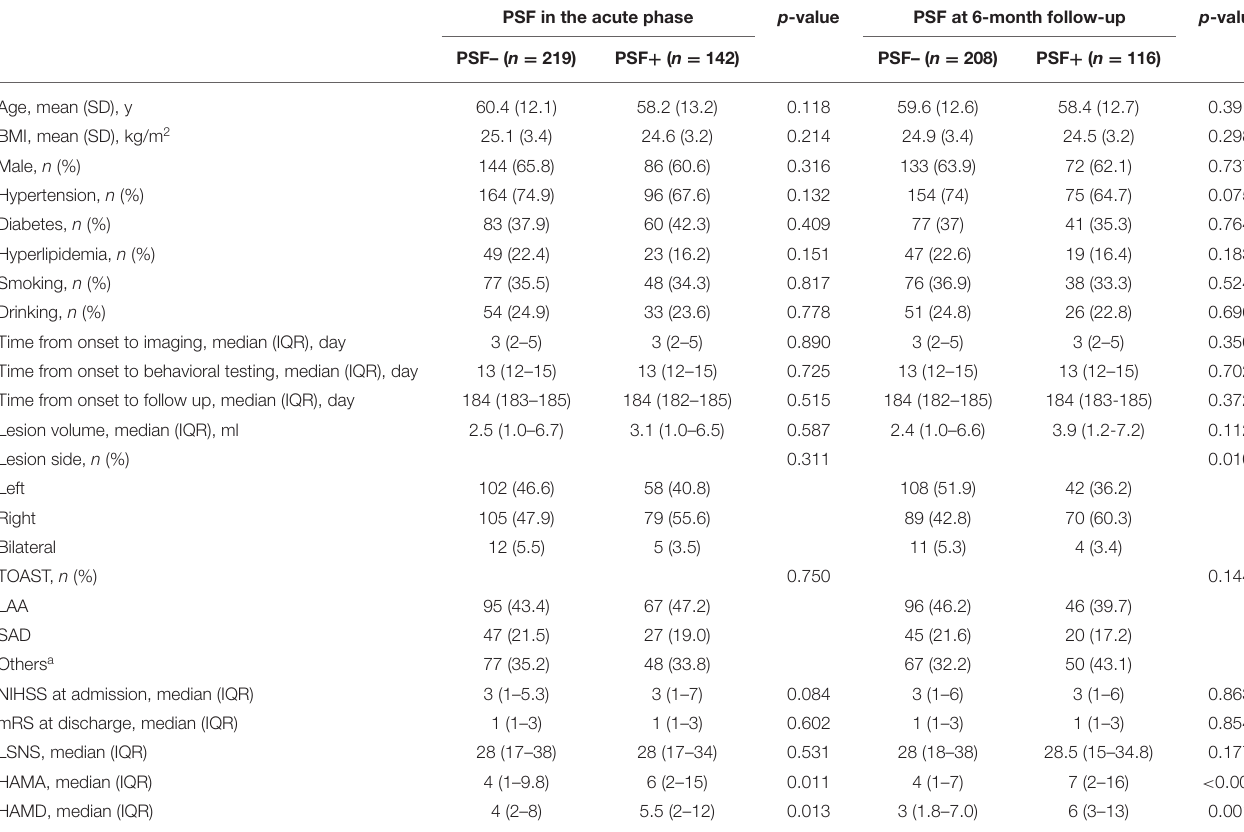
TABLE 1 | Baseline characteristics and neuropsychological scores of poststroke fatigue in the acute phase and 6-month follow-up.